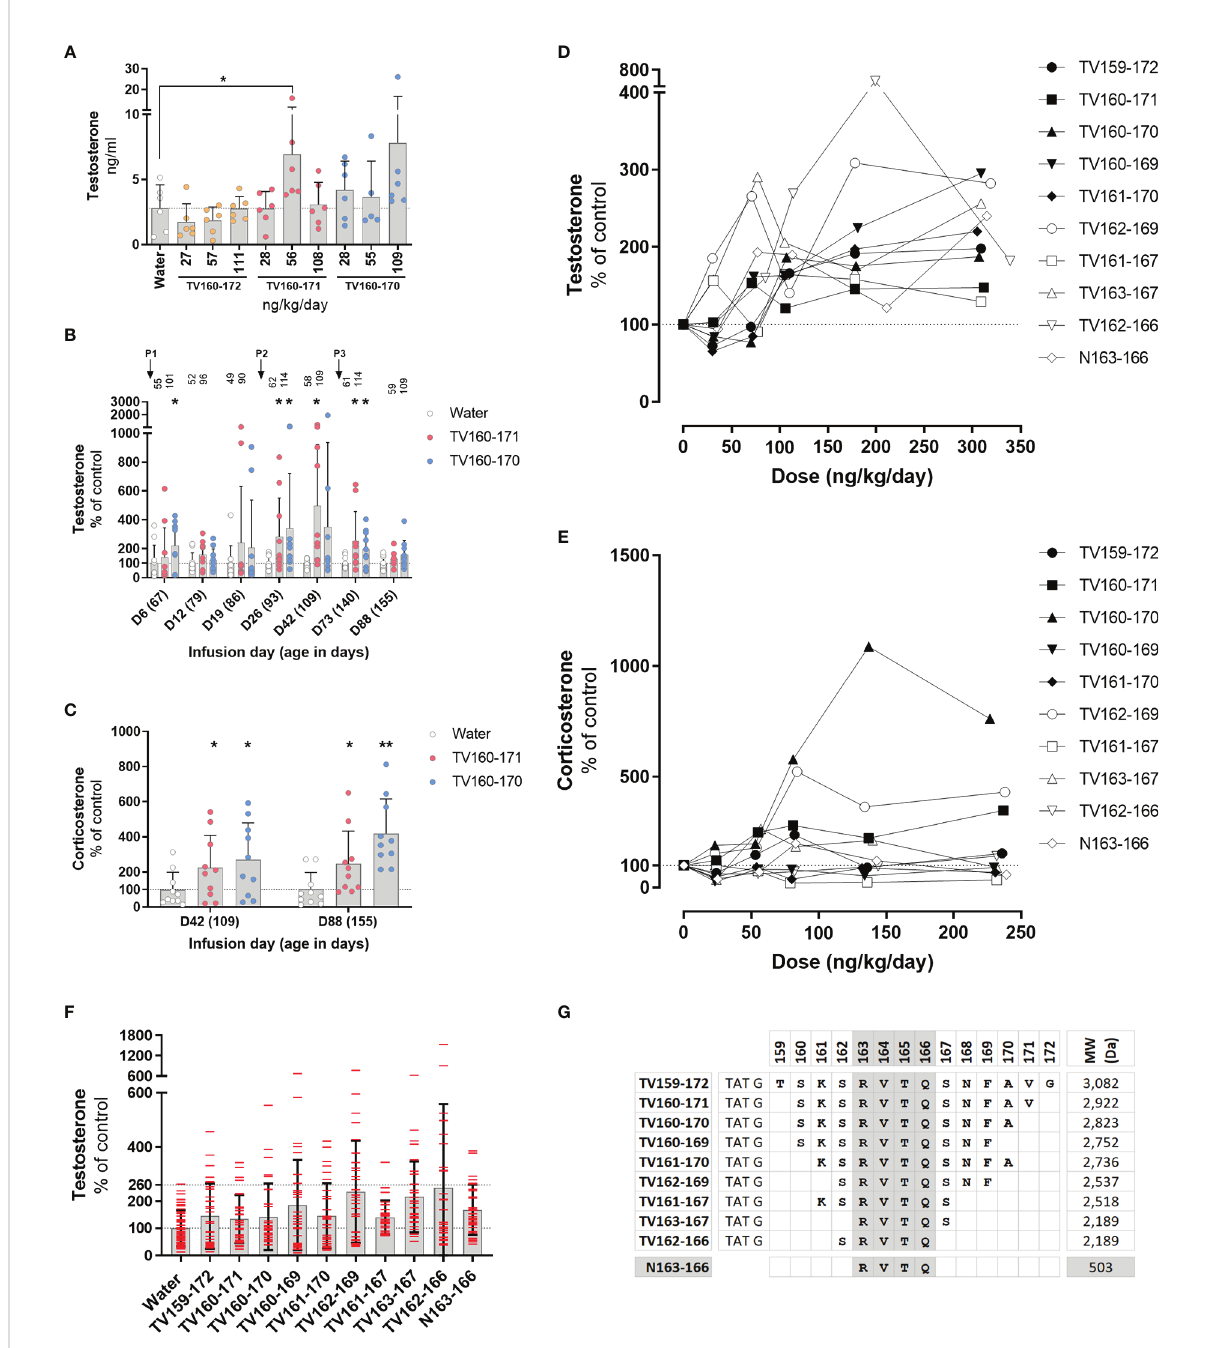
FIGURE 3 (A – C) TV160-171 and TV160-170 increase steroid levels. (A) Plasma testosterone levels in Sprague-Dawley treated with various concentrations of TV160-172, TV160-171, and TV160-170 for 1 week. (B) Plasma testosterone levels in Sprague-Dawley rats treated chronically with TV160-171 and TV160-170. The arrows depict the subcutaneous implantation of the infusion pumps. Peptide levels (ng/kg/day) delivered at the time of sampling are depicted on top of each bar. (C) Corticosterone levels in plasma samples from rats treated with TV160-171 and TV160-170 collected at infusion day 42 and 88. Data shown represents means ± standard deviation (N = 10); p*< 0.05, p**<0.01. (D – F) Deletions of TV159- 172 retain androgenic activity. (D) Testosterone plasma levels in Brown-Norway rats implanted with subcutaneous pumps delivering increasing concentrations of indicated TV159-172 peptides. (F) Pooled testosterone levels of all water-treated rats and each peptide, independent of the dose. Data shown represents means ± standard deviation (N=6); p* < 0.05, p**<0.01. (G) Peptides were composed of TAT sequence, glycine linker, and the VDAC1-derived sequence shown in